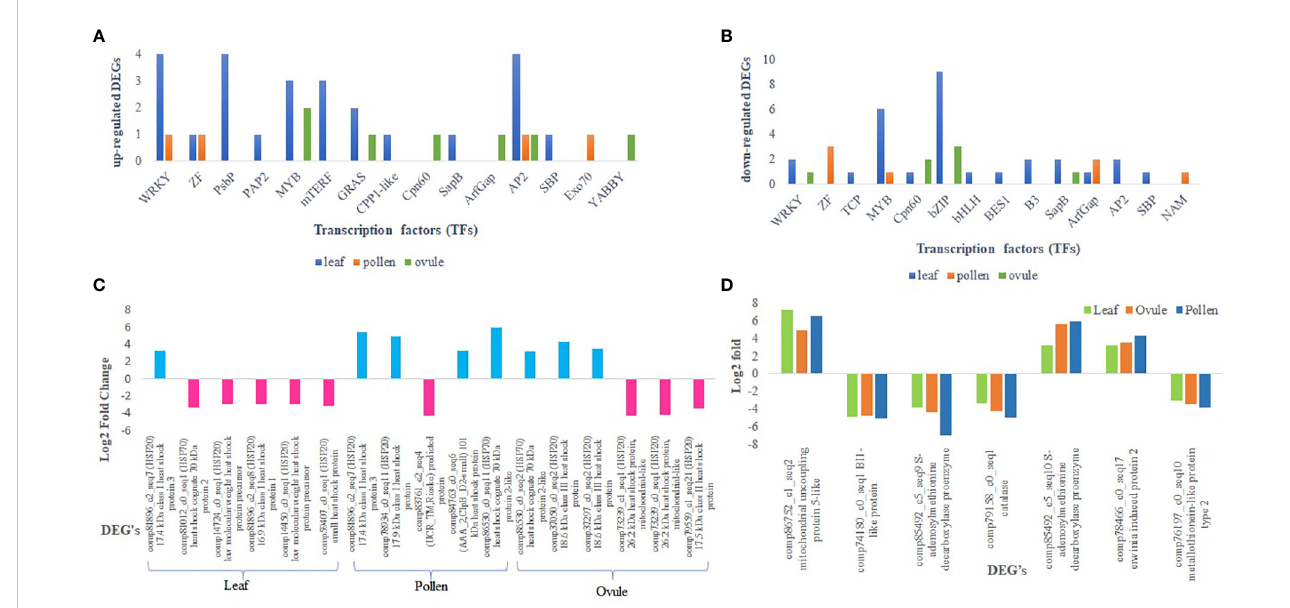
FIGURE 5 Differential expression of representative genes involved in molecular function in response to heat stress. (A) Transcription factors those are commonly up-regulated in leaf and ovule, and leaf and pollen. (B) Transcription factors those are commonly down-regulated in leaf and ovule, and leaf and pollen. (C) Relative expression of heat shock proteins (HSPs) in leaf, pollen, and ovule. The blue color indicates the DEGs are up-regulated and the pink color indicates DEGs are down-regulated. (D) Graphical representation of commonly expressed DEGs in leaf, pollen and ovule that are involved in the polyamine biosynthesis